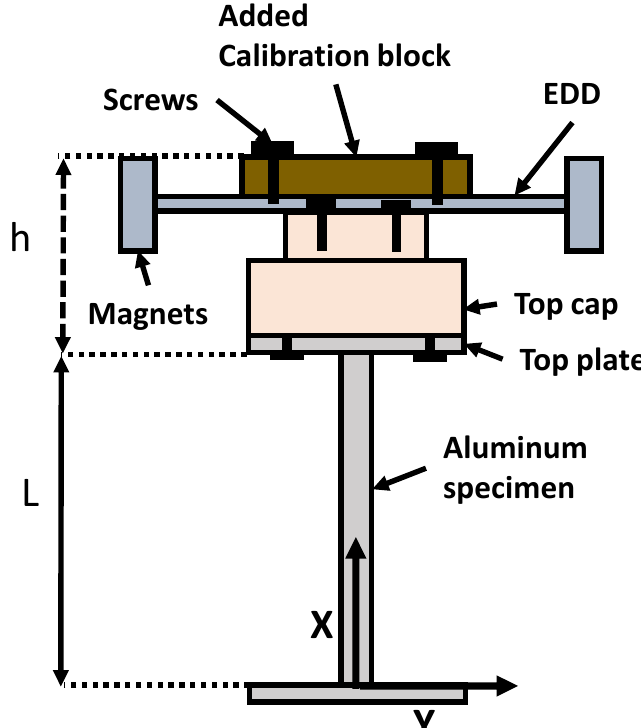
Figure 3. Calibration rod resonant test configuration diagram.